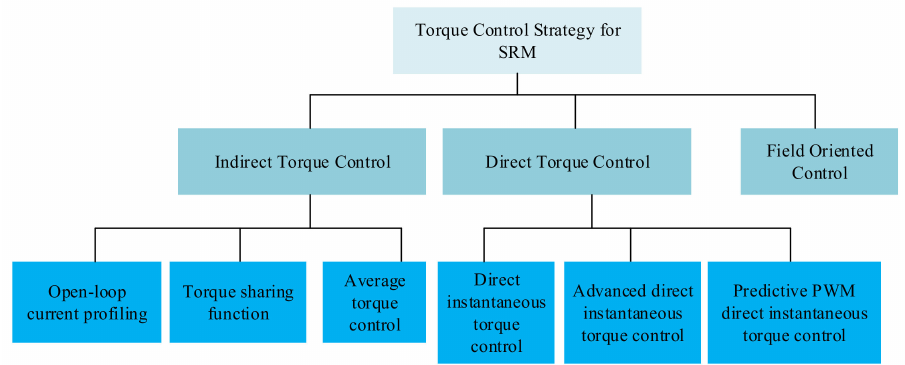
Figure 22. Torque control strategies.